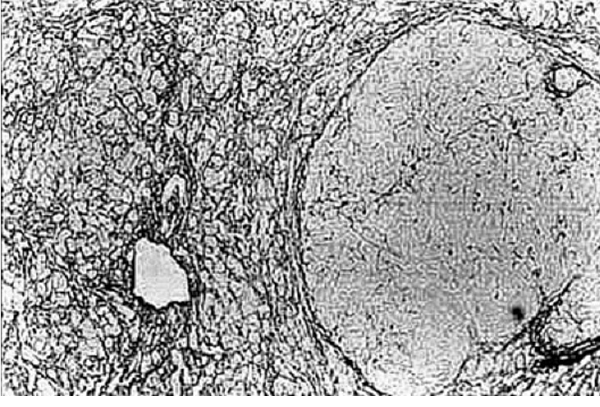
Gross photograph showing reticulated cut surface; liver cap-sule is opaque and corrugated